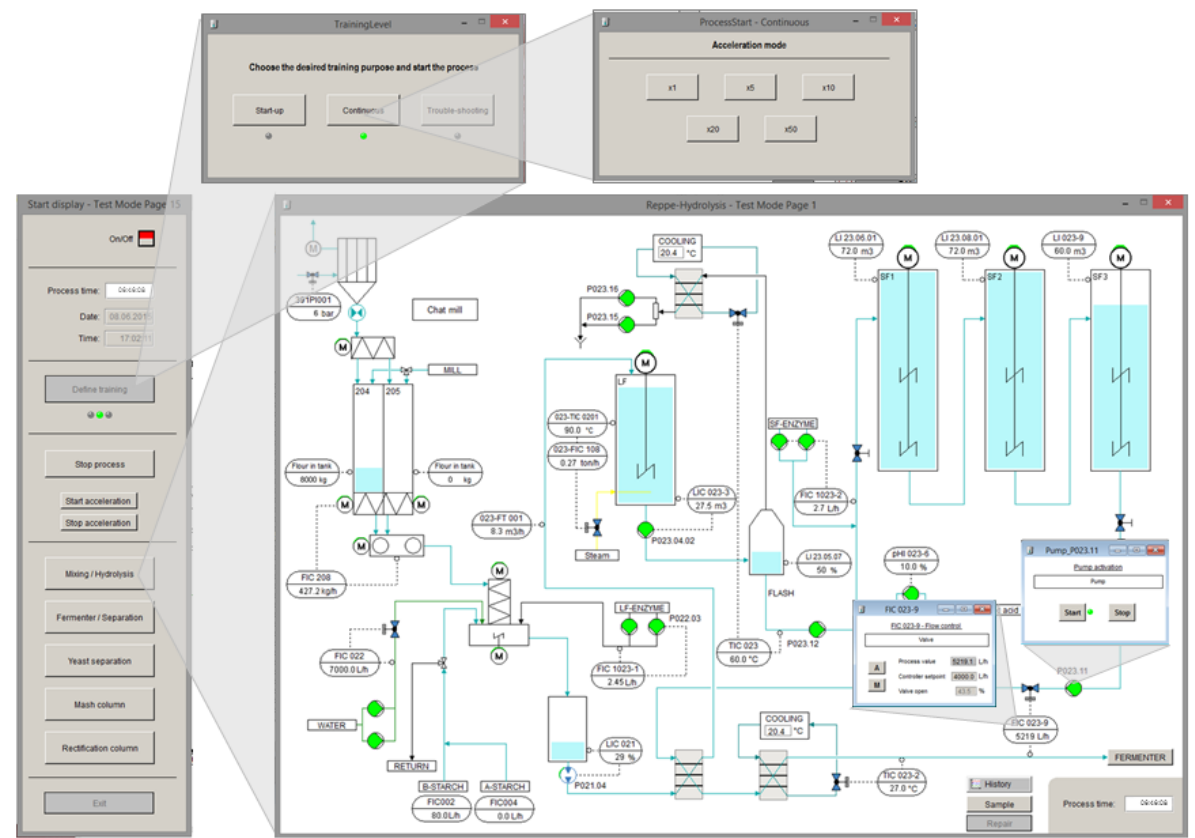
Figure 6. Example of GUIs of the OTS as designed from the conceptual design premises. The figures shows the hydrolysis process section of the virtual plant with sub-windows (above and inside main window) for start/stop, settings of valves and pumps that are comparable to the real DCS. An additional start-window (left) displays key features of the OTS including the visualization of the virtual process time. Via different buttons the user can define the training configuration and the acceleration mode, as well as open additional GUIs, e.g. for changing the